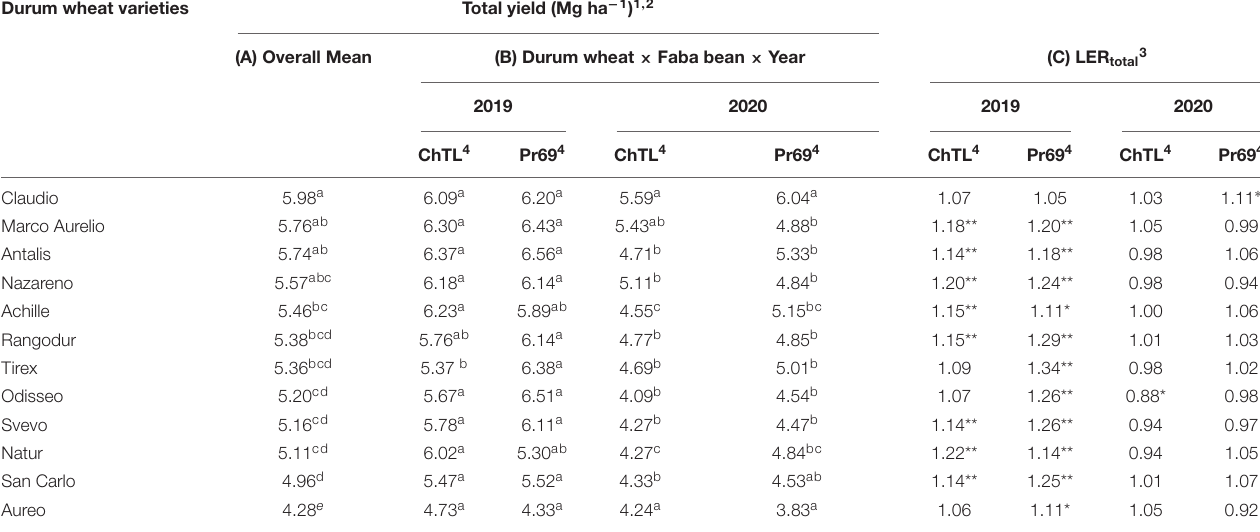
TABLE 3 | Total yield and LER total . Durum wheat varieties